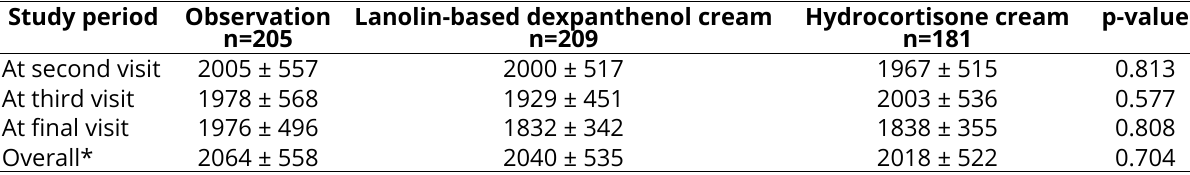
Table 3. Mean doses of capecitabine along the study (mg/m 2